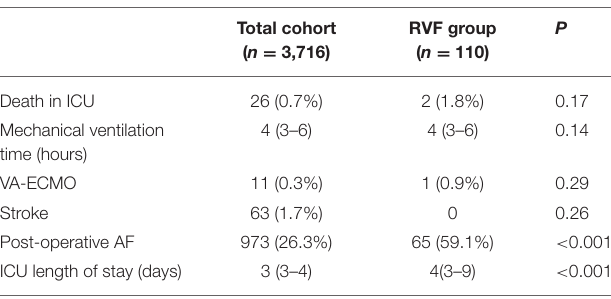
TABLE 2 | Post-operative